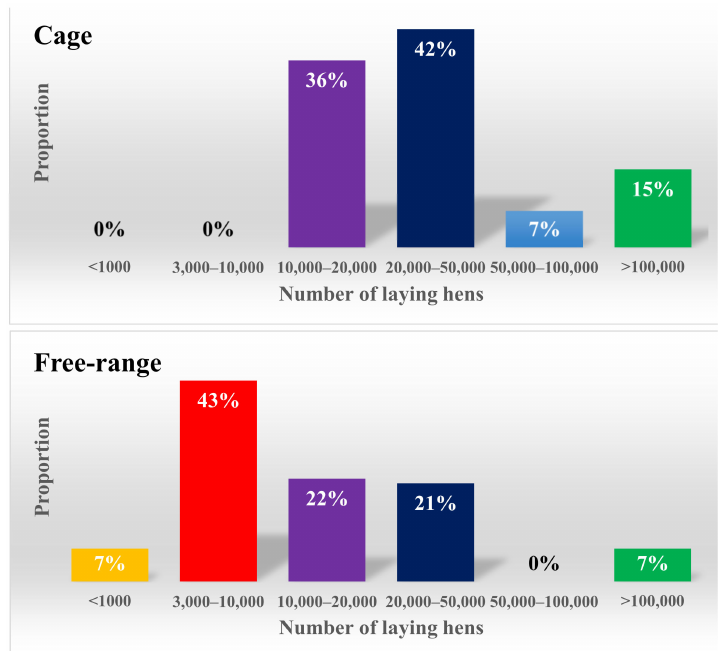
Figure 2. Number of hens in participating cage and free-range